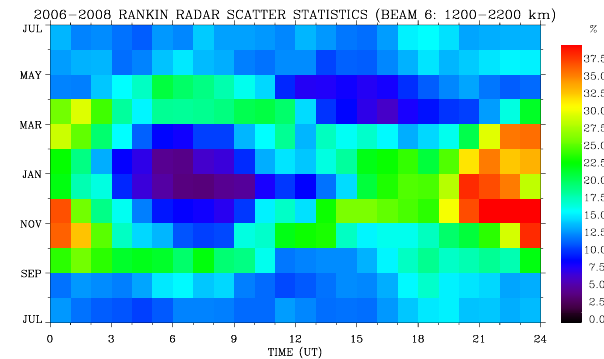
Fig. 8. The average σ φ for Resolute Bay from September 2008 to August 2009. Magnetic local midnight and noon at Resolute Bay occur around 07:10 and 19:40UT, respectively.